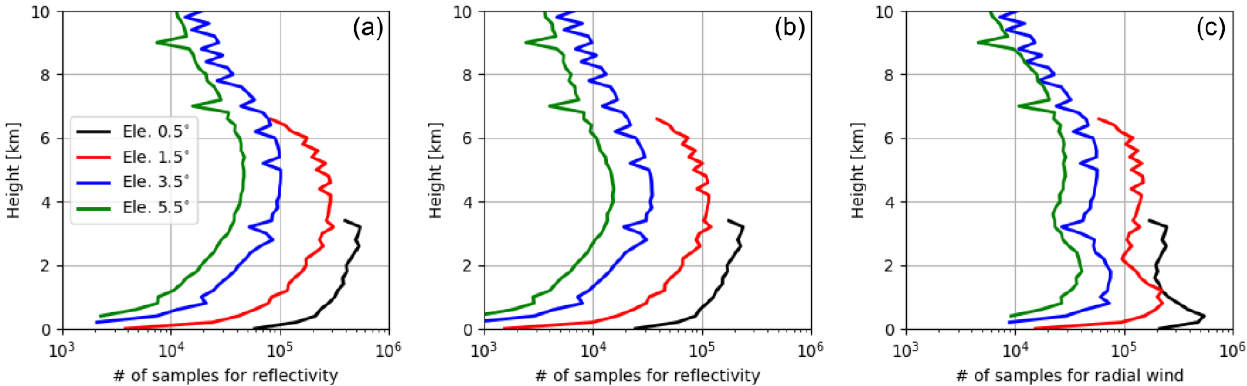
Figure A6. Vertical profiles of numbers of samples used for estimating standard deviations of the OE for reflectivity data ≥ 0dBZ (a) and ≥ 5dBZ (b) and for radial wind (c) at elevations of 0 . 5, 1 . 5, 3 . 5 and 5 . 5 ◦